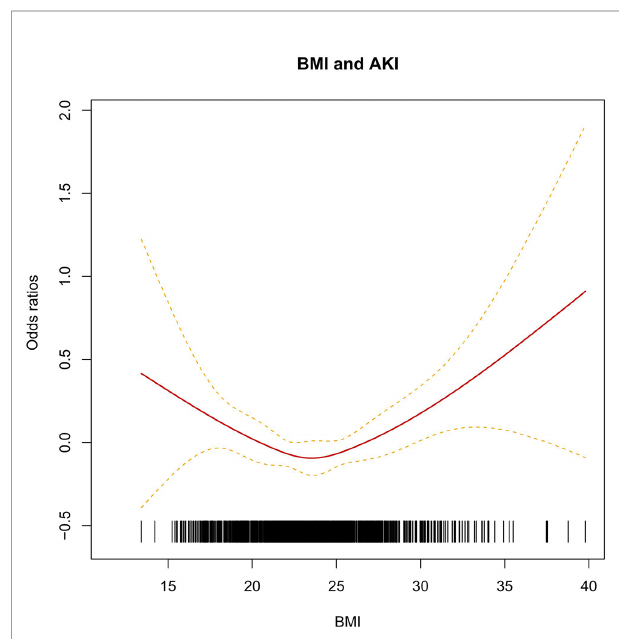
FIGURE 1 | The linear relationship between BMI and AKI. The short black vertical line respect different BMI of individuals. The red solid line and the dash line respect the estimated relative risk and its 95% CI.